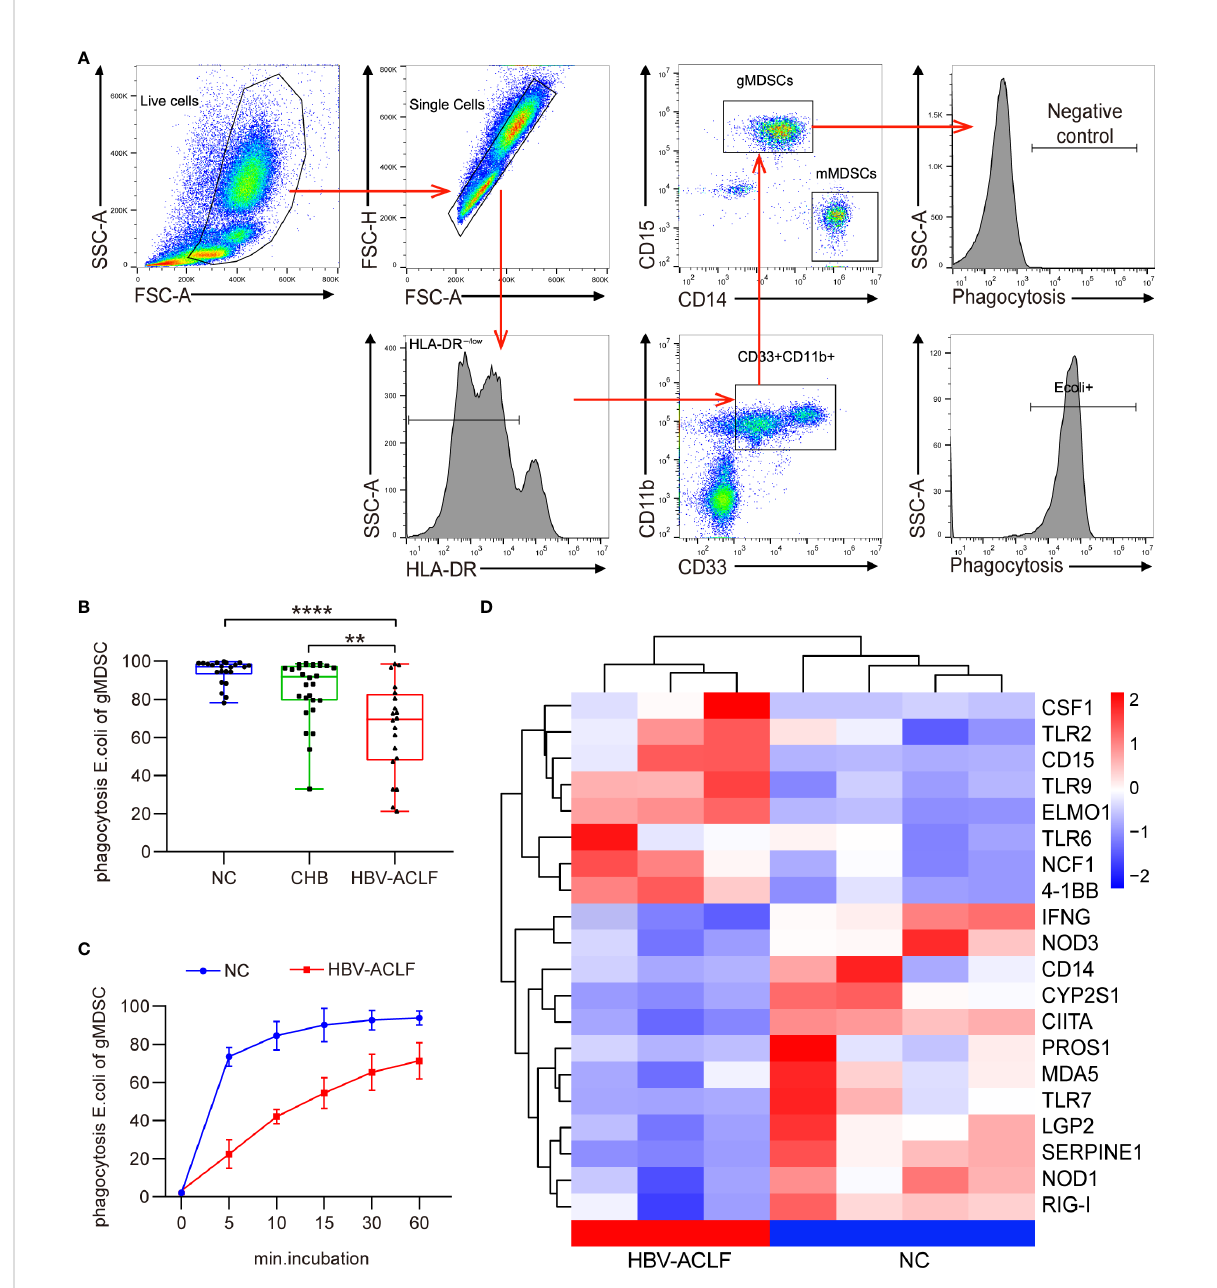
FIGURE 6 gMDSC from HBV-ACLF patients display impaired phagocytosis of E. coli . (A) Representative FACS (A) and cumulative dot plot (B) showing gMDSC phagocytosis of E. coli in HC, CHB, and HBV-ACLF groups. (C) Time-dependent analysis of phagocytosis assay in HC and HBV-ACLF patients. (D) Heat map of differential mRNA expression in gMDSC from HC (n = 4) and HBV-ACLF patients (n =